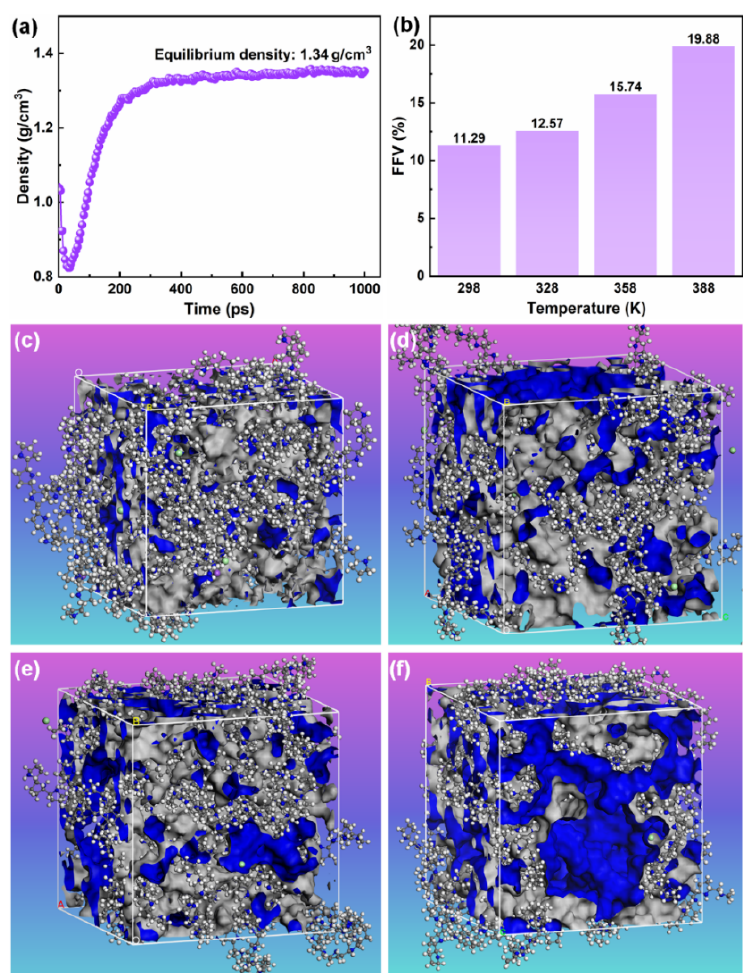
Figure 7. Equilibrium density of PPy coating system ( a ) and fraction of free volume ( b ) of each coating model after dynamic relaxation under 298, 328, 358 and 388 K along with the corresponding presentations in ( c )–( f ), respectively.